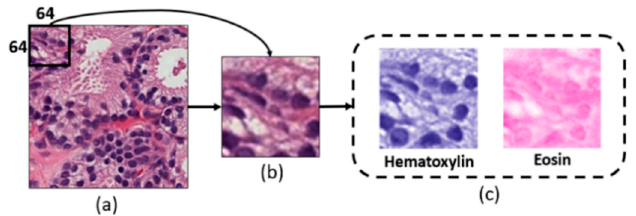
Figure 4. Block diagram of patch extraction and stain deconvolution of histopathological images. ( a ) The preprocessed regions of interest (ROI) after gamma correction. ( b ) Patch extraction of size